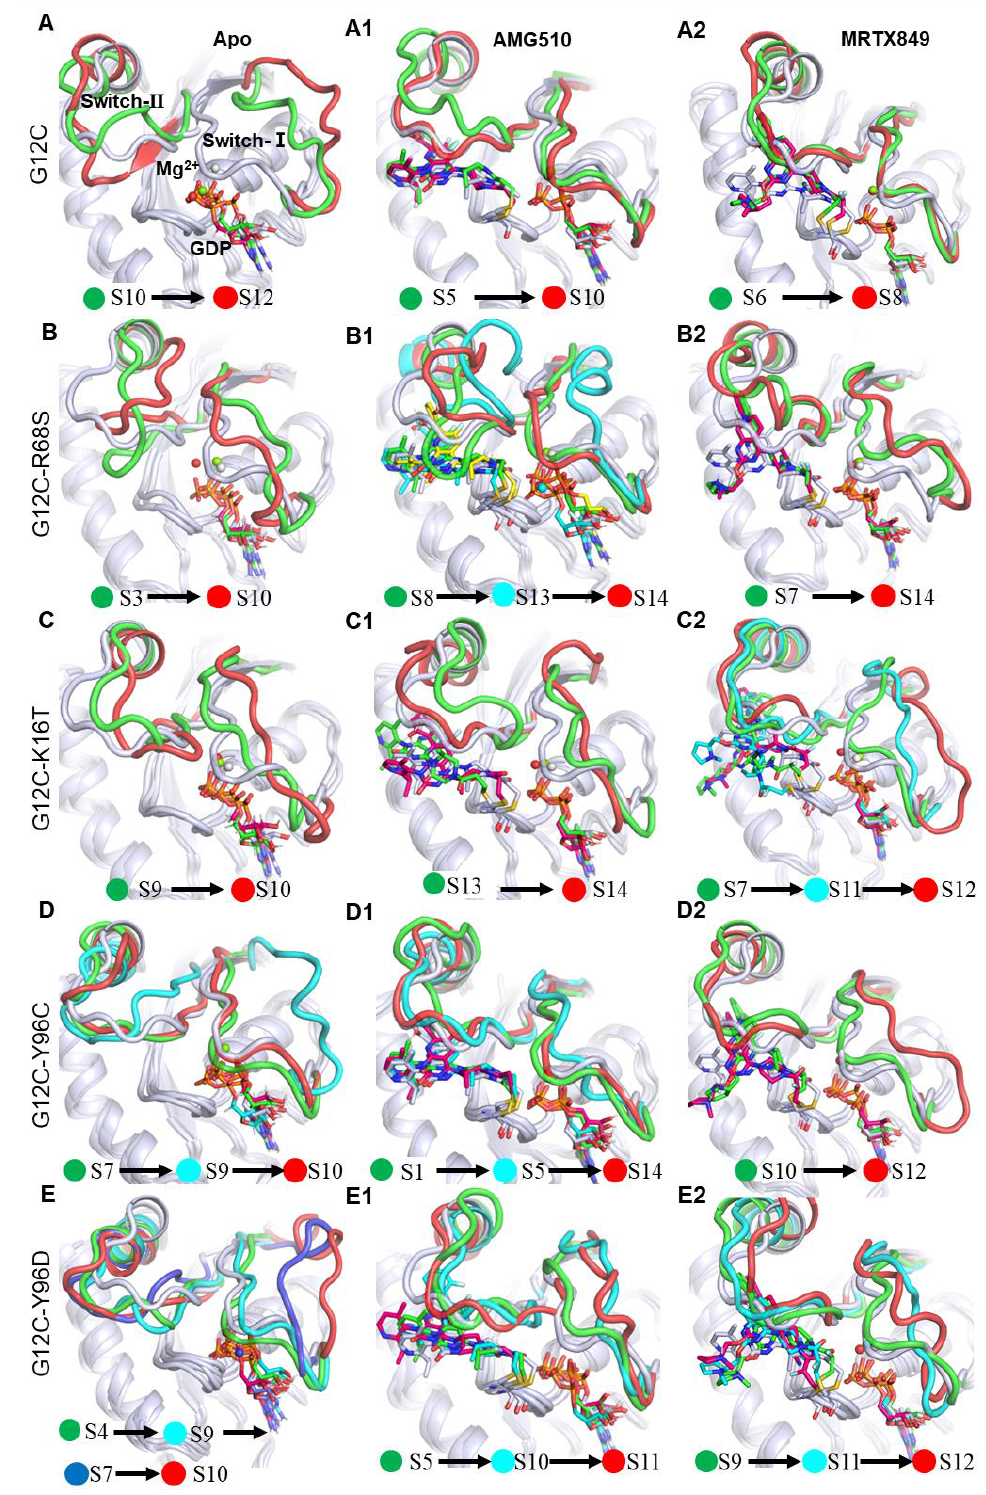
Figure 8. The main flux metastable state (Si) with one representative structure were identified for each system, and the initial crystal structure of KRAS G12C is shown in gray color. The green and cyan (or yellow) label denotes the start and end state. ( A – E ) The apo form KRAS G12C and four second-site mutilation KRAS. The AMG510 ( A1 – E1 ) and MRTX849 ( A2 – E2 ) bound to KRAS G12C and four second-site mutation KRAS. The metastable state (Si) conformations with a total of probability flux > 60.0% are depicted by cartoon.